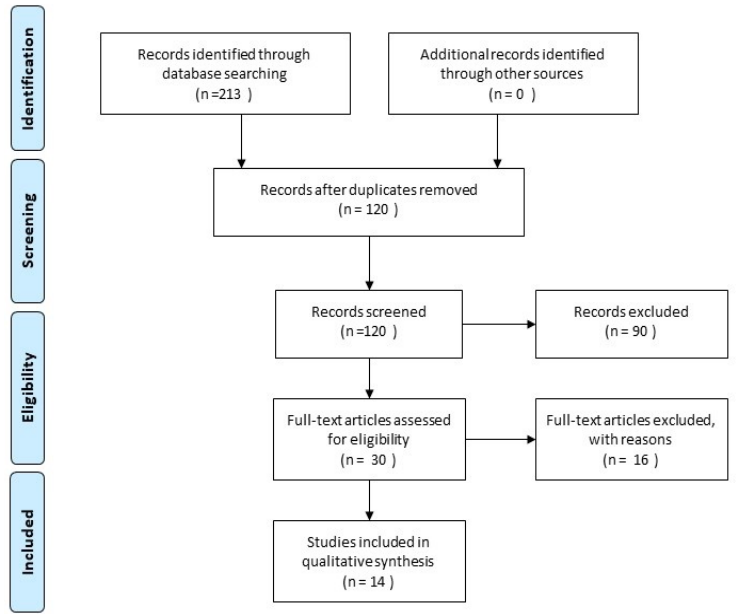
Figure 1. A search flowchart according to the Preferred Reporting Items for Systematic Reviews and Meta-Analyses statement.